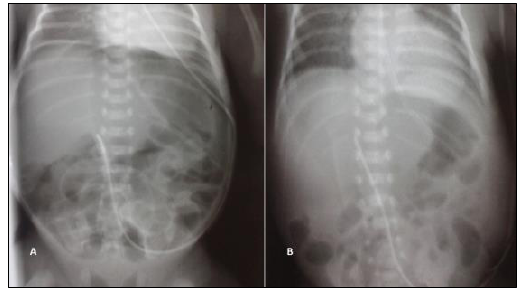
Figure 1: A- Pneumoperitoneum. B- Resolution of pneumo- peritoneum after peritoneal needle suction. The baby was intubated because his